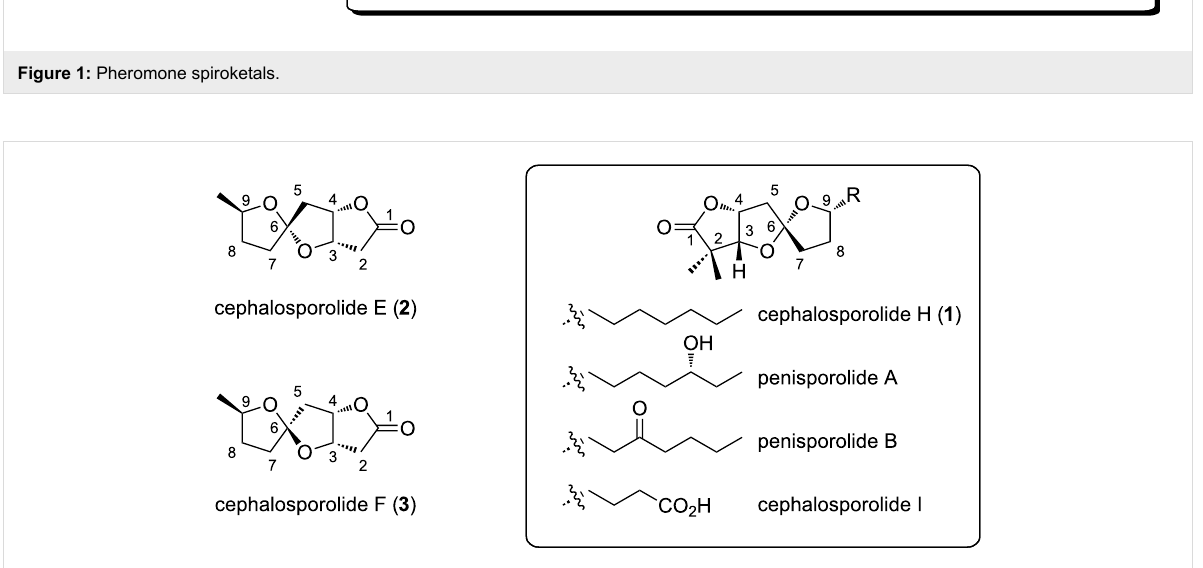
Figure 2: Reported structures of the cephalosporolides and